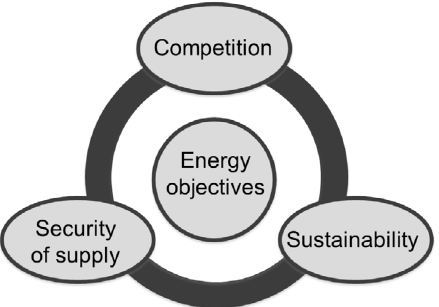
Fig. 1. Central energy system design objectives. (Adapted from [3].)